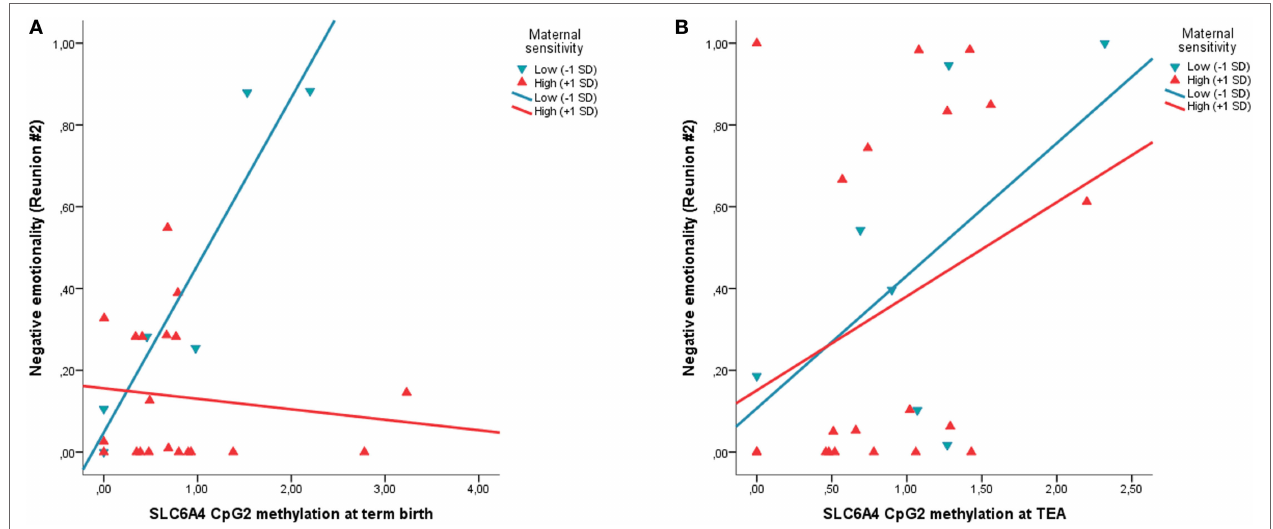
FigUre 3 | The moderating role of maternal sensitivity is observed on the association between SLC6A4 CpG-specific methylation at birth in FT infants (a) , but not on the association between SLC6A4 CpG-specific methylation at discharge in VPT infants (B) . Circles and dotted lines represent infants from low-sensitive mothers ( − 1 SD). Squares and continuous lines represent infants from high-sensitive mothers ( + 1 SD). Negative emotionality is measured as the proportion of time on the entire Reunion #2 episode; SLC6A4 , serotonin transporter gene; CpG2, chr17: 28562786-28562787, − 72 pb from the TSS; FT, full-term; VPT, very